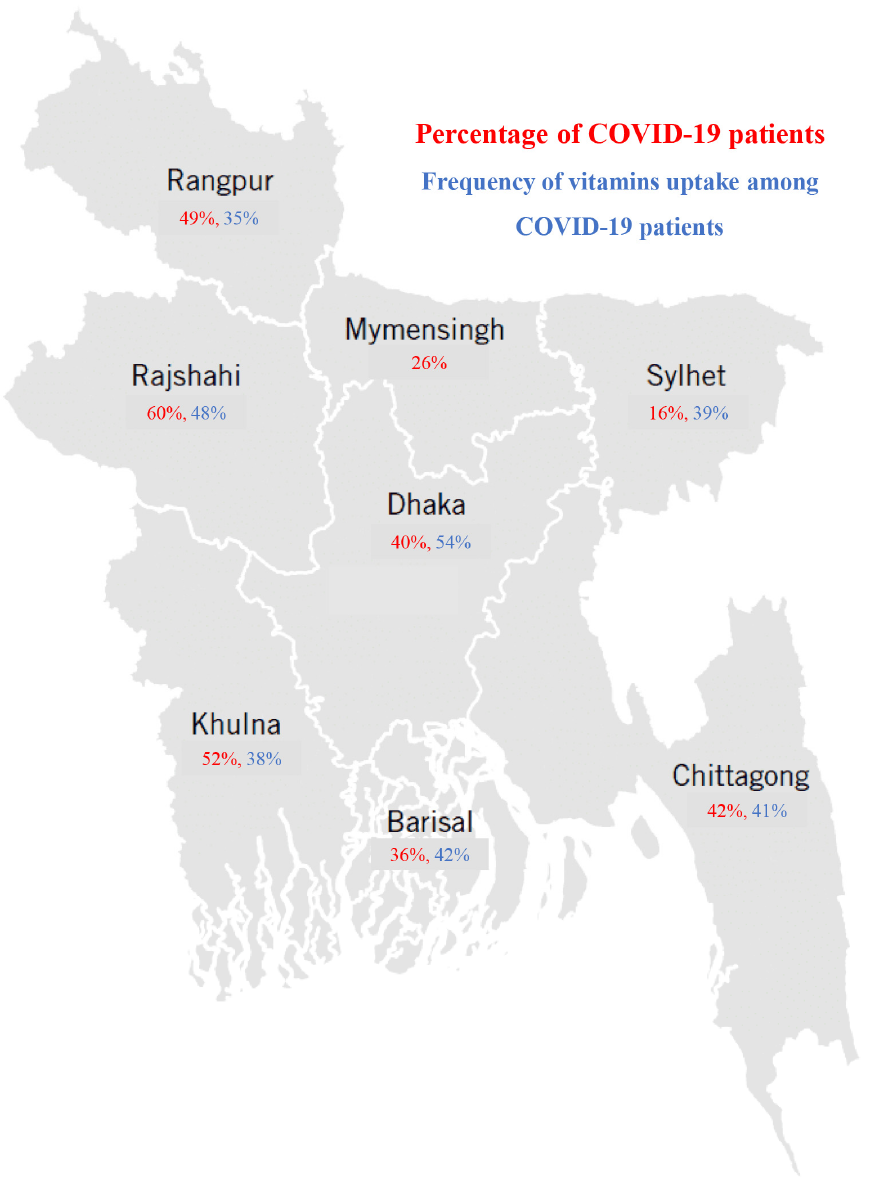
Figure 1. Nationwide frequency distribution of participants and COVID-19 patients.